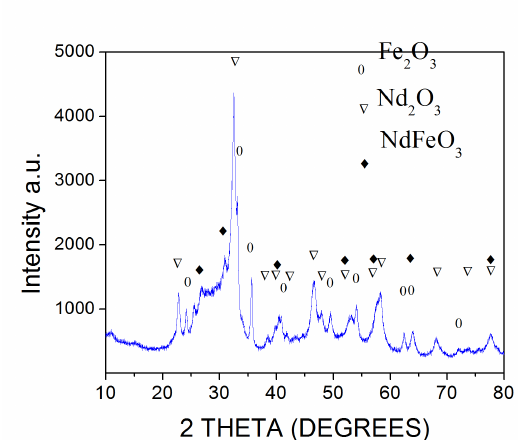
Fig. 2 XRD pattern of powder obtained after 4.5 h of milling from Nd